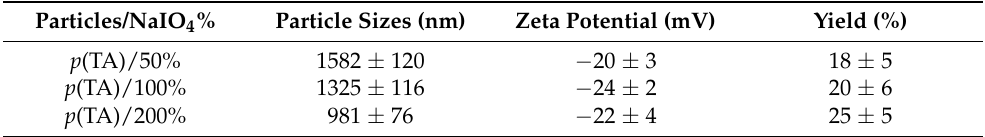
Table 1. The sizes (nm) *, zeta potential (mV), and gravimetric yields (%) of p (TA) particles prepared by using different amounts of NaIO 4 as mole% based on TA molecules particles. Particles/NaIO 4